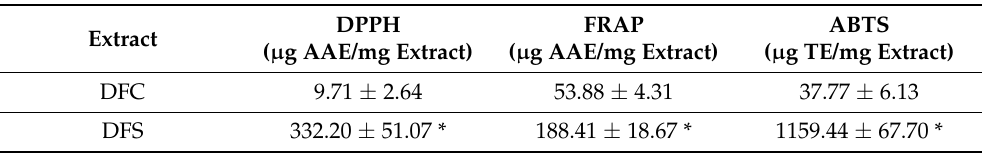
Table 1. Effects of culture medium supplementation on DPPH and ABTS radical scavenging and FRAP reducing activities in DFC and